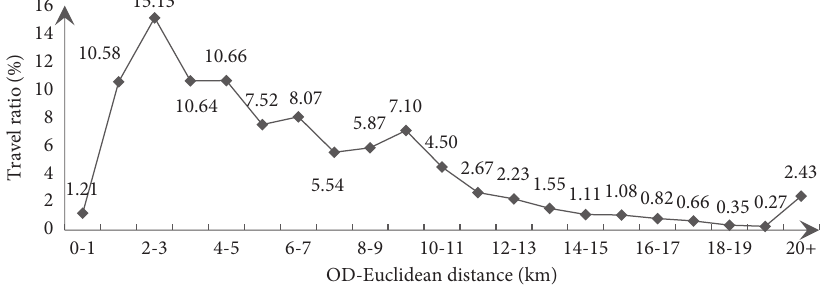
Figure 4: OD-Euclidean distance distribution of 11 drop-off